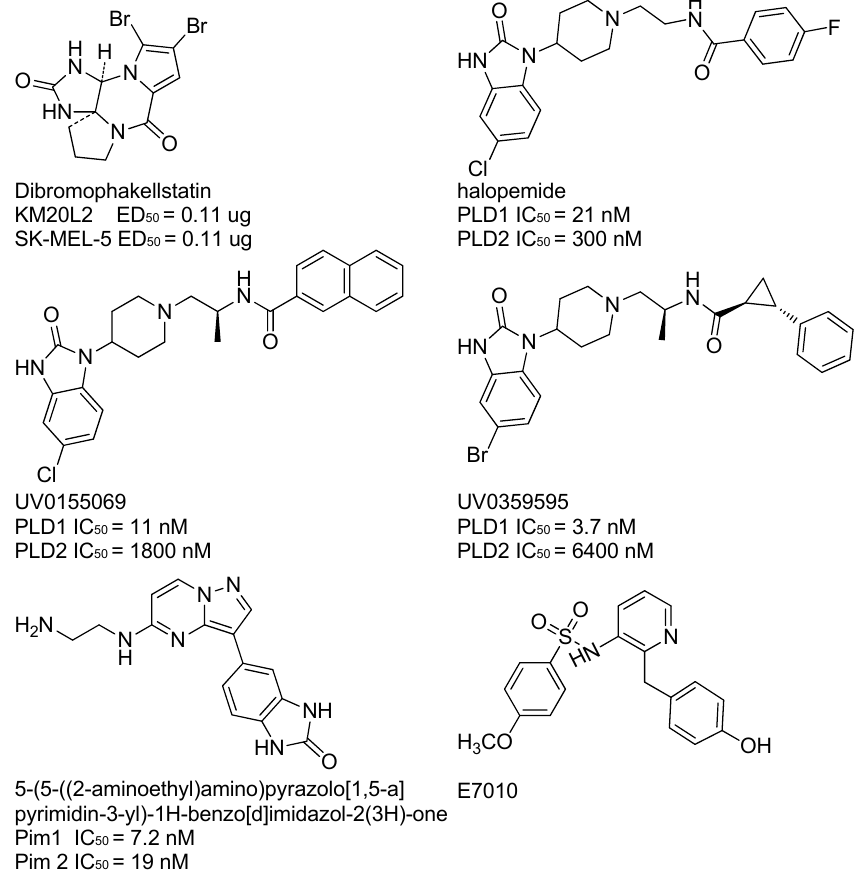
Figure 1. Structures and activities of dibromophakellstatin 1A, halopemide 2A, isoform-selective PLD (PLD1 selective) inhibitors 3A and 4A, Pim 1/2 inhibitor 5-(5-((2-aminoethyl)amino)pyrazolo [1,5- a ]pyrimidin-3-yl)-1 H -benzo[d]imidazol-2(3 H )-one , tubulin inhibitor E7010.